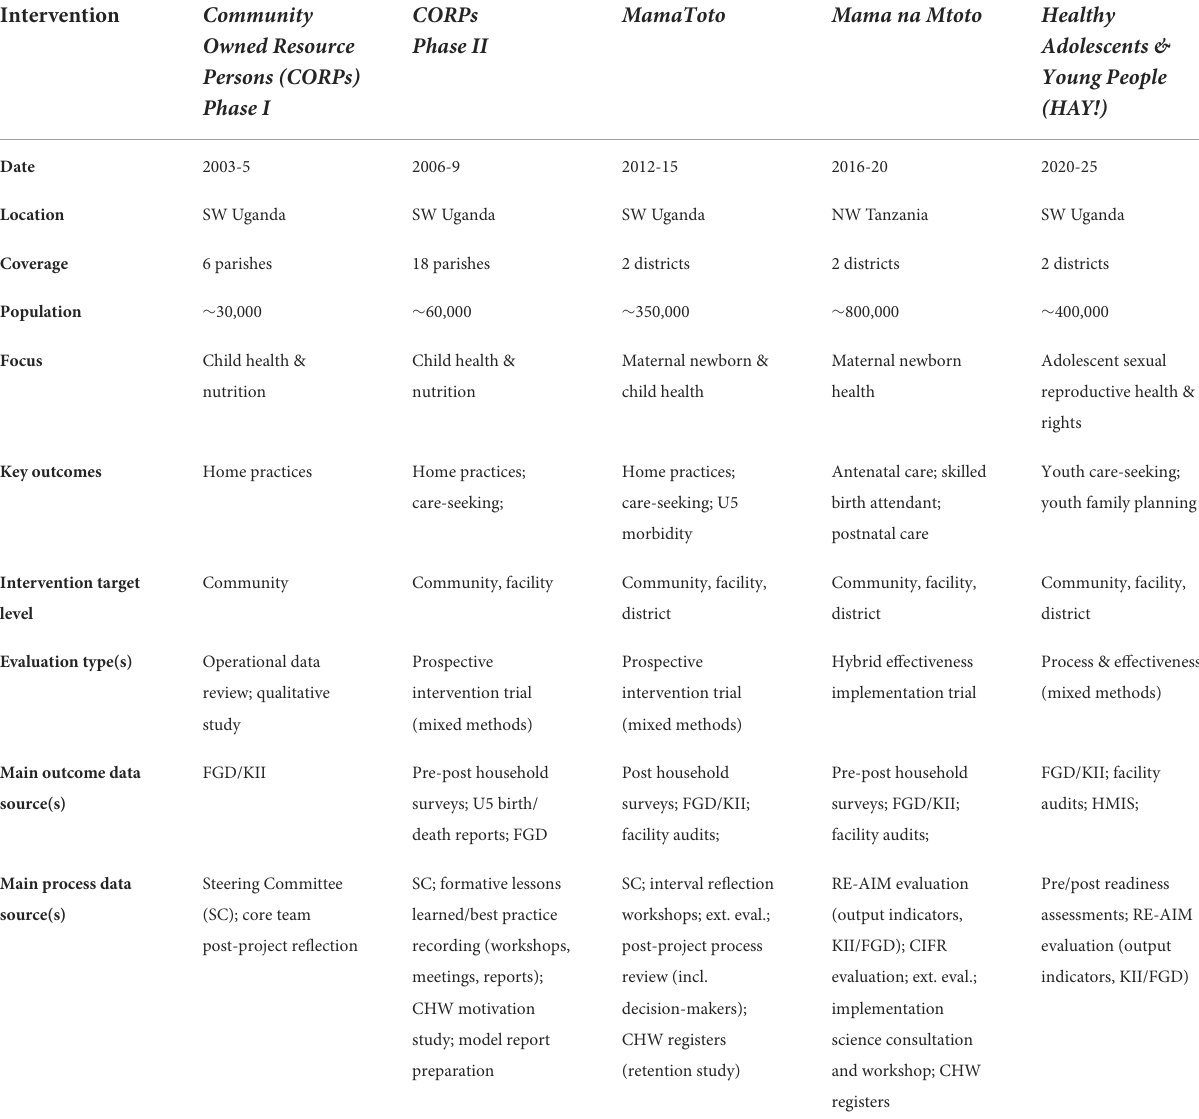
TABLE 1 Features of key MERI- informing interventions,